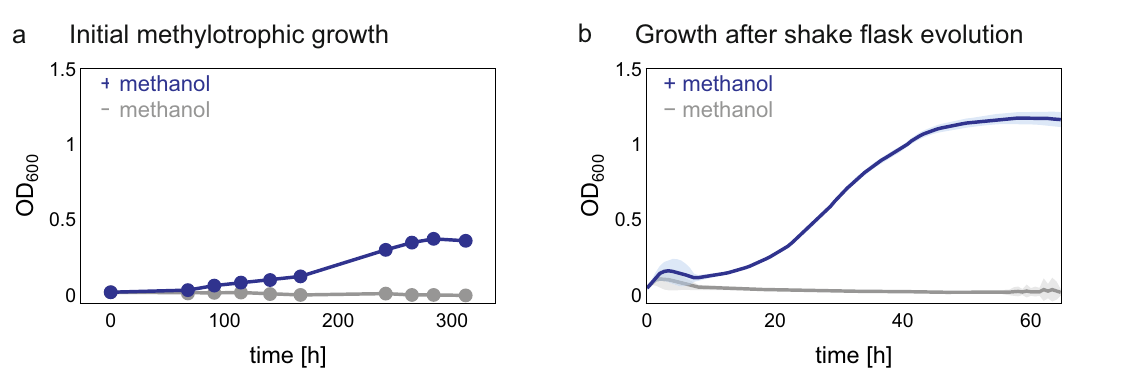
Fig. 3 | Growth on methanol in the absence of pyruvate of the evolved E . coli . a Growth phenotype of the evolved population after 249 generations in the che- mostat,inthepresenceandabsenceofmethanol.Growthwasexaminedinminimal medium containing 500mM methanol, ampicillin and streptomycin. b Growth phenotype of MEcoli_ref_1 in minimal medium supplemented with 500mM